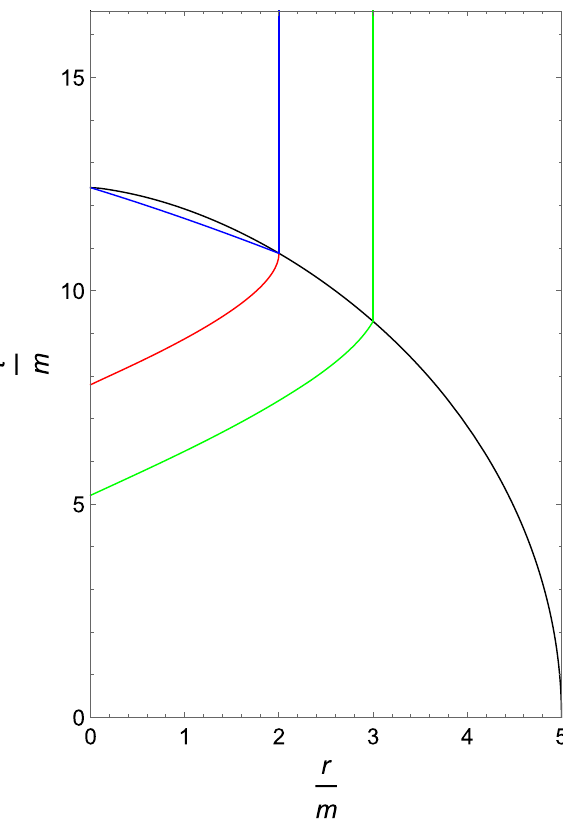
Fig. 2 OS model for the gravitational collapse of homogenous dust. The green line corresponds to the photon surface, the red line is the event horizon, and the blue line is the apparent horizon